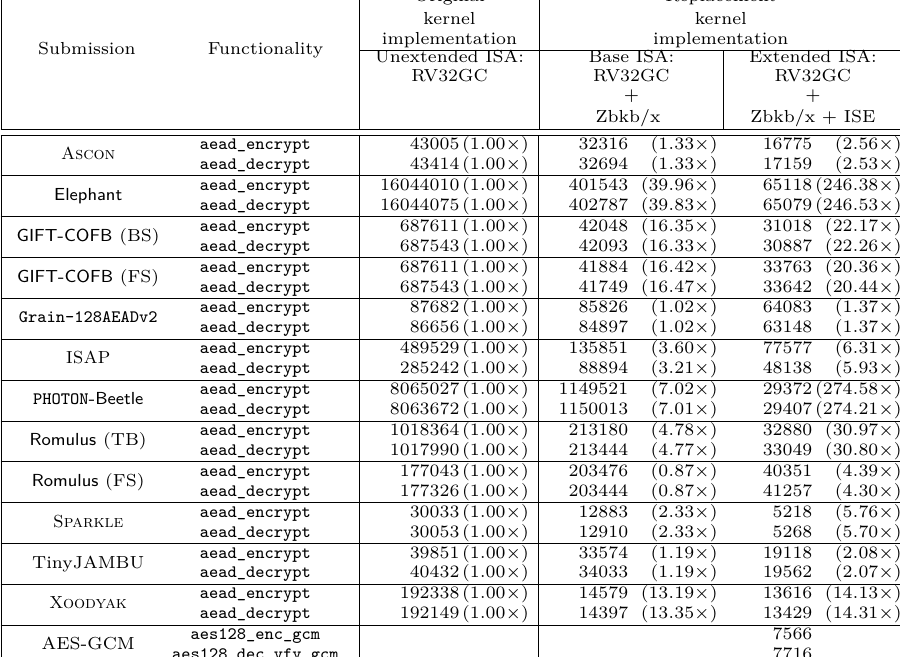
Table 5: Software-oriented evaluation, i.e., utilisation of each ISE design: latency measured in clock cycles (plus increase/decrease factor versus unextended ISA in parentheses) for indirect kernel use via AEAD API (with 128 B plaintext, ciphertext, and associated